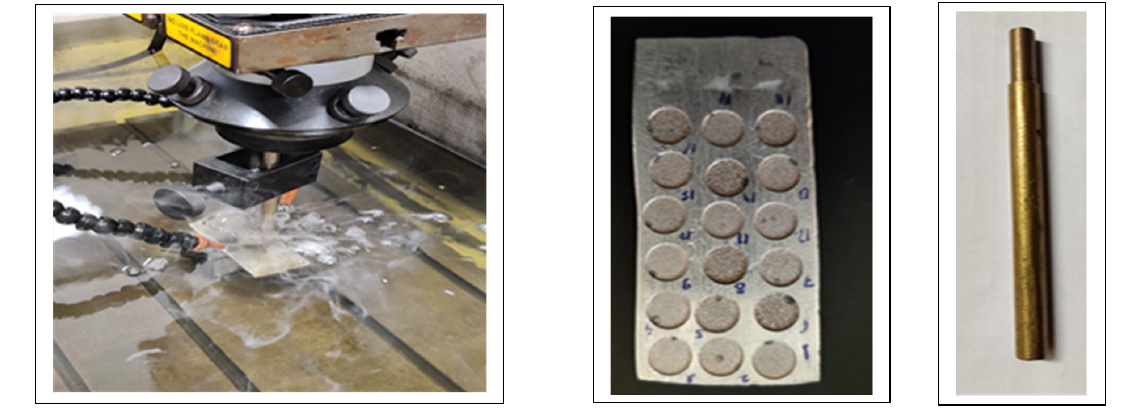
Fig. 3. Schematic showing Machining in EDM Fig. 4. Schematic of (a) work piece (b) Brass